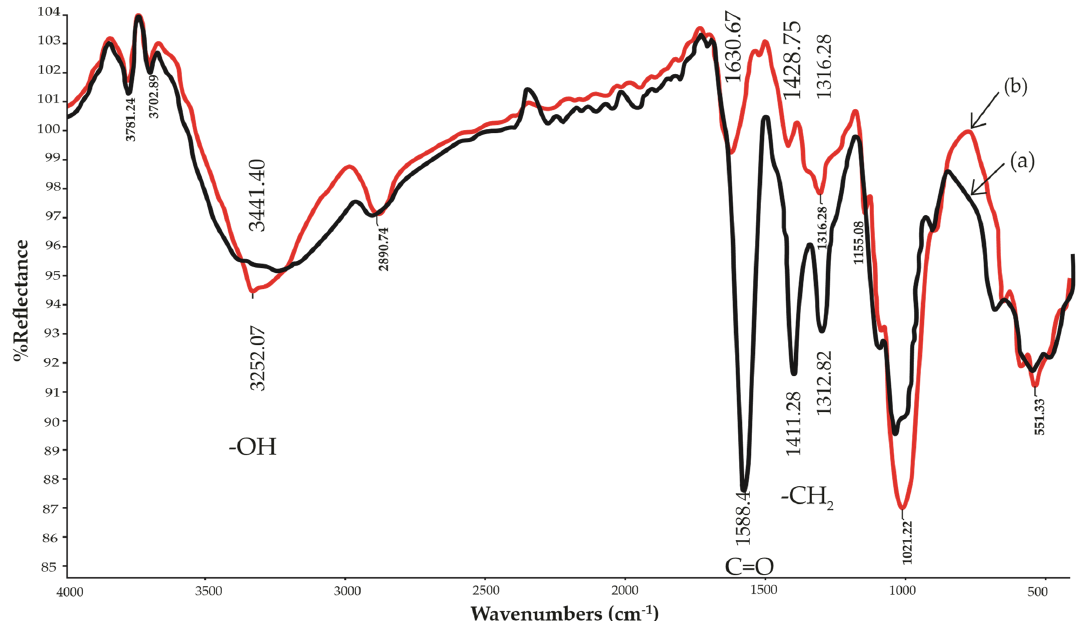
Figure 4. Fourier transform infrared spectroscopy of ( a ) bacterial cellulose from nata de coco and ( b ) CMC n synthesized with 24 g MCA/15 g cellulose.